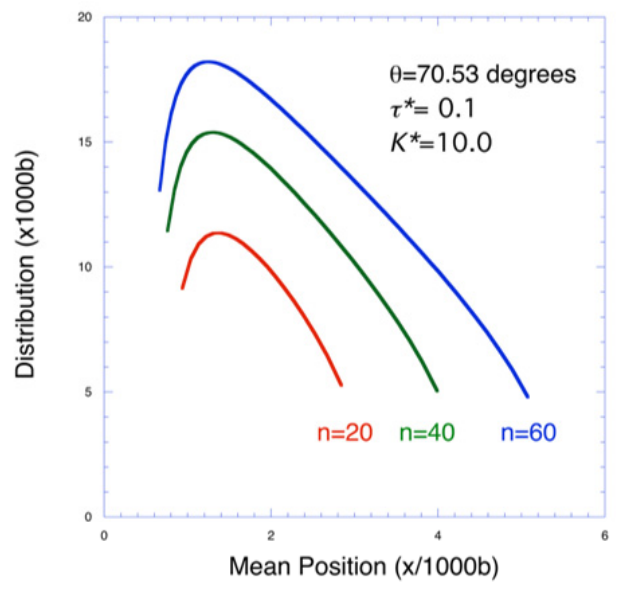
Figure 8. The diagram showing the first and last equilibrium positions as a function of the number of = 0.1. dislocations for θ = 70.54 and τ ∗ i